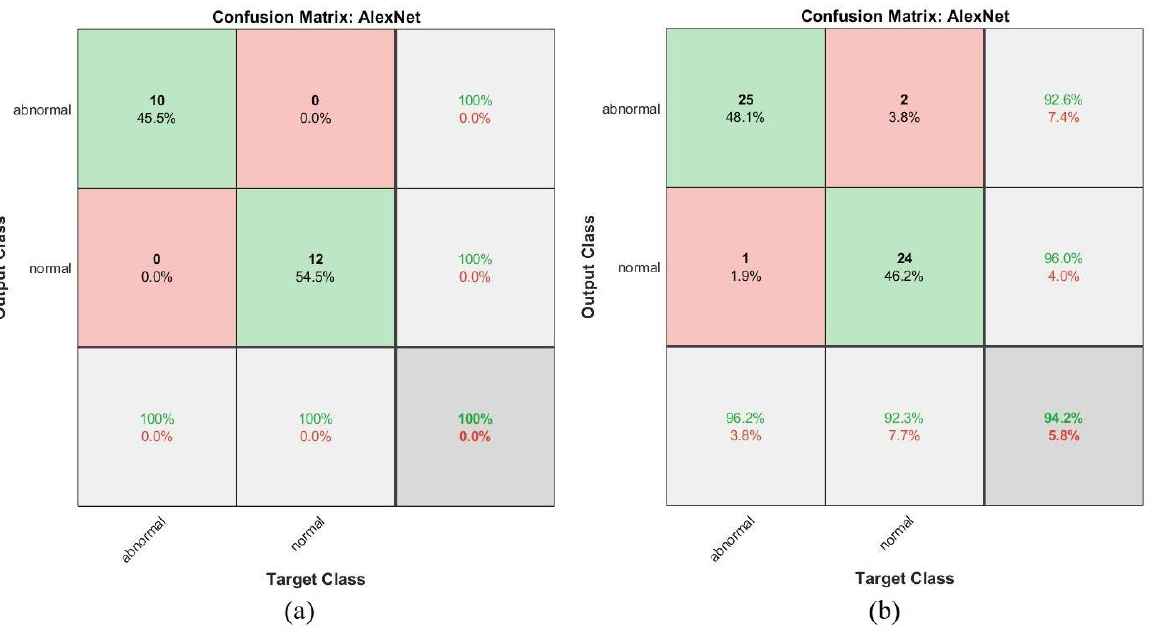
Figure 23. Confusion matrix for the GoogLeNet model for the ( a ) ALL_IDB1 and ( b ) ALL_IDB2 datasets.